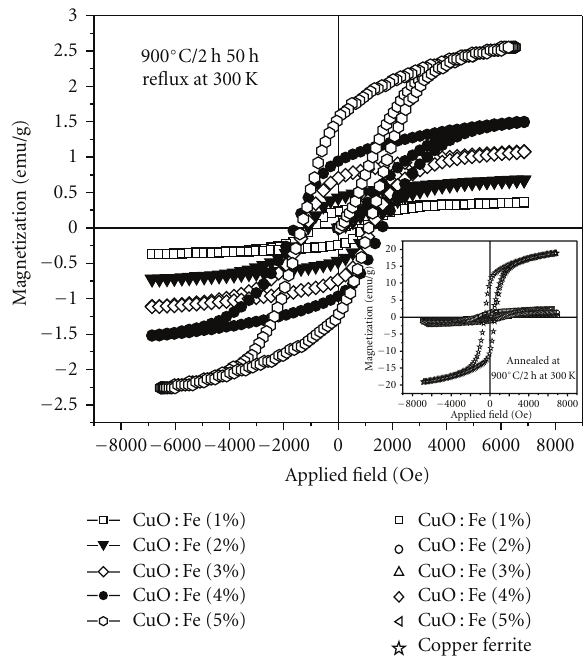
Figure 11: Increase in magnetization ( M max ) as a function of % of “Fe” in CuO at 300K for the 50-hour refluxed nanocrystalline sample annealed at 900 ◦ C/2h in air. Inset shows the comparison with pure copper ferrite.